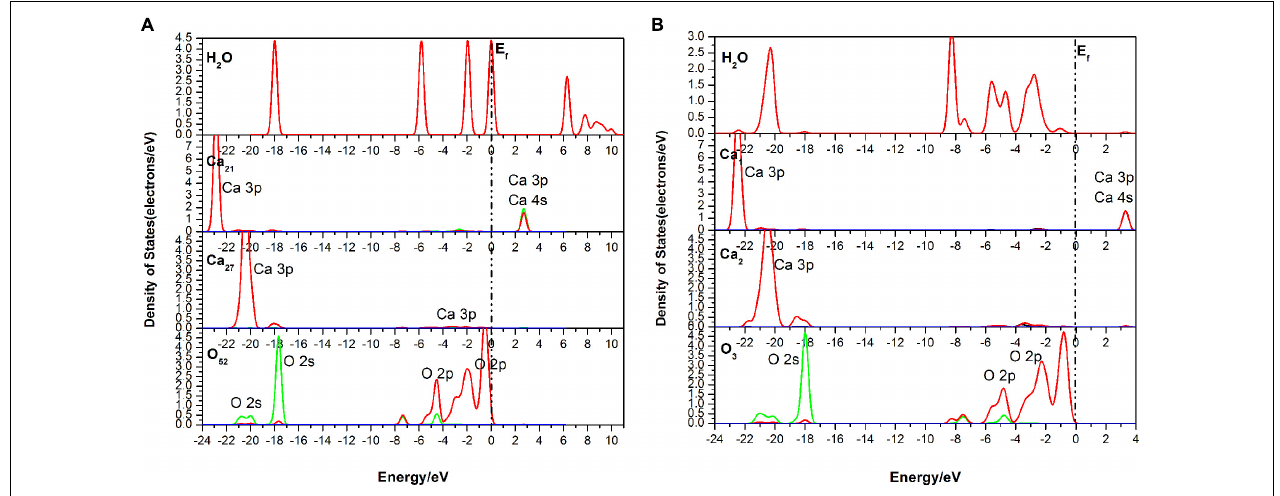
FIGURE 7 | Densities of states (DOS) of the corresponding atoms of the three-site adsorption: (A) before adsorption; (B) after adsorption.